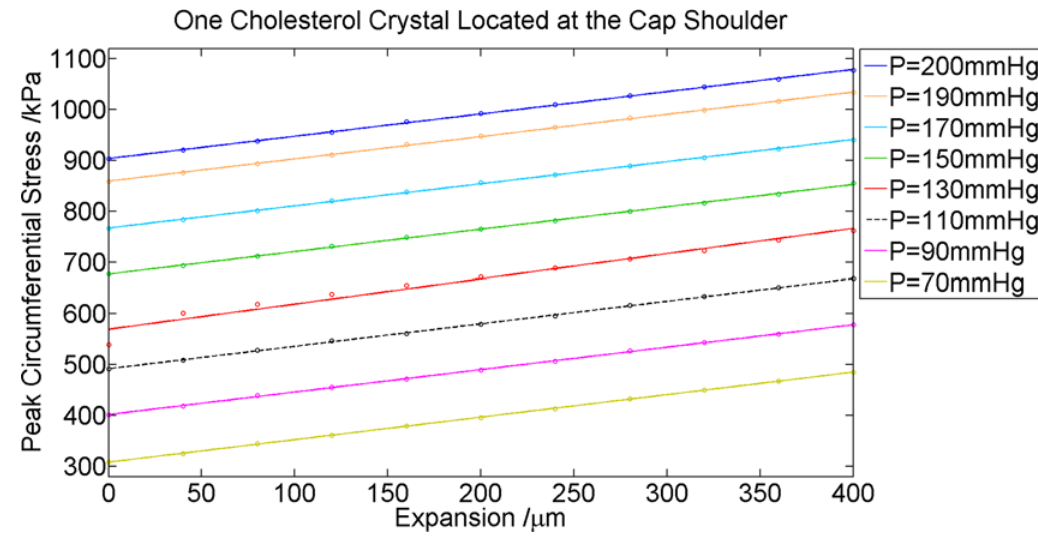
Fig 11. Effect of crystal expansion at the Cap Shoulder on Peak Circumferential Stress with Varying Blood Pressure. P : intracoronary blood